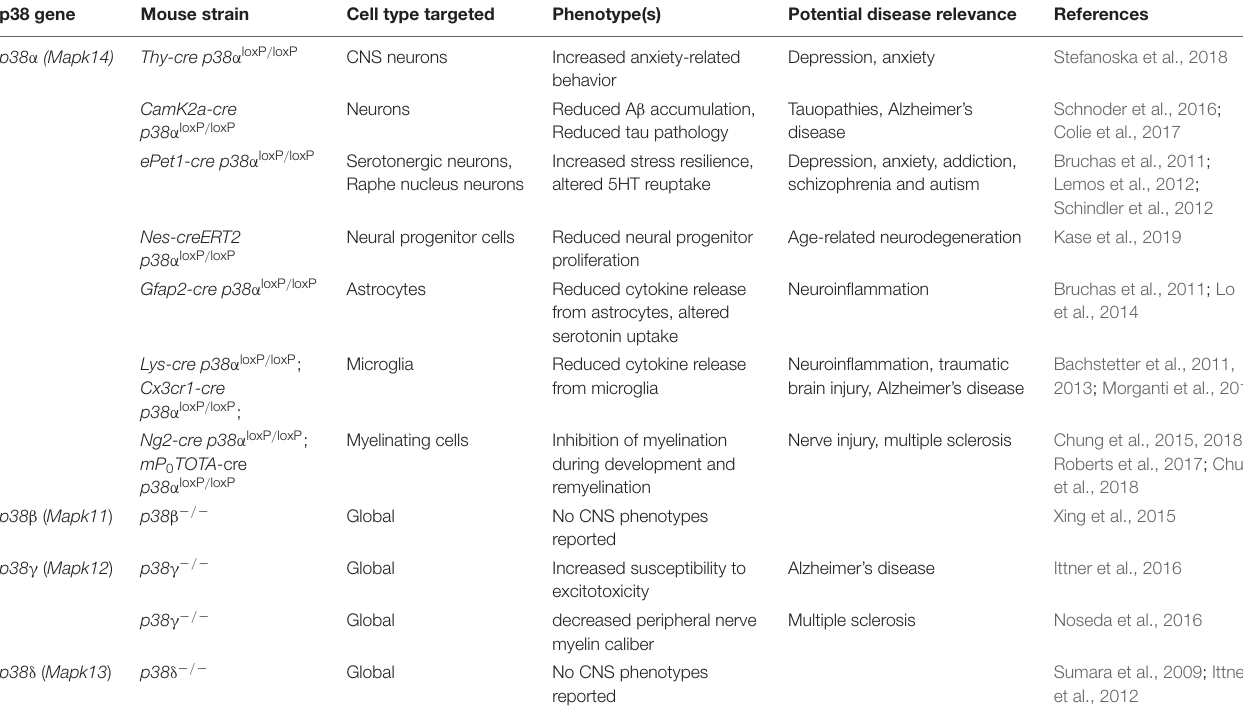
TABLE 3 | Mouse models of p38 gene targeting in and affecting functions of CNS